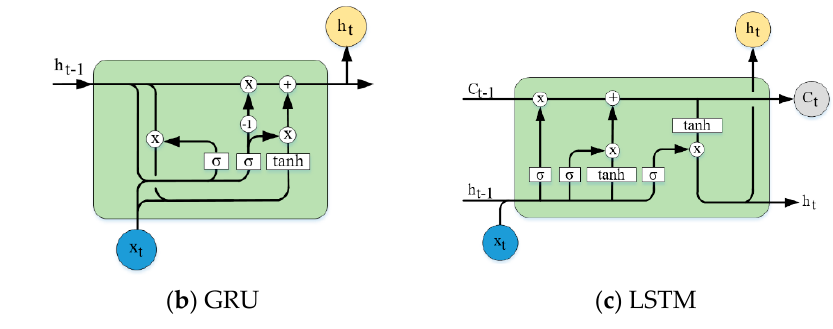
Figure 2. Recurrent neural network types .